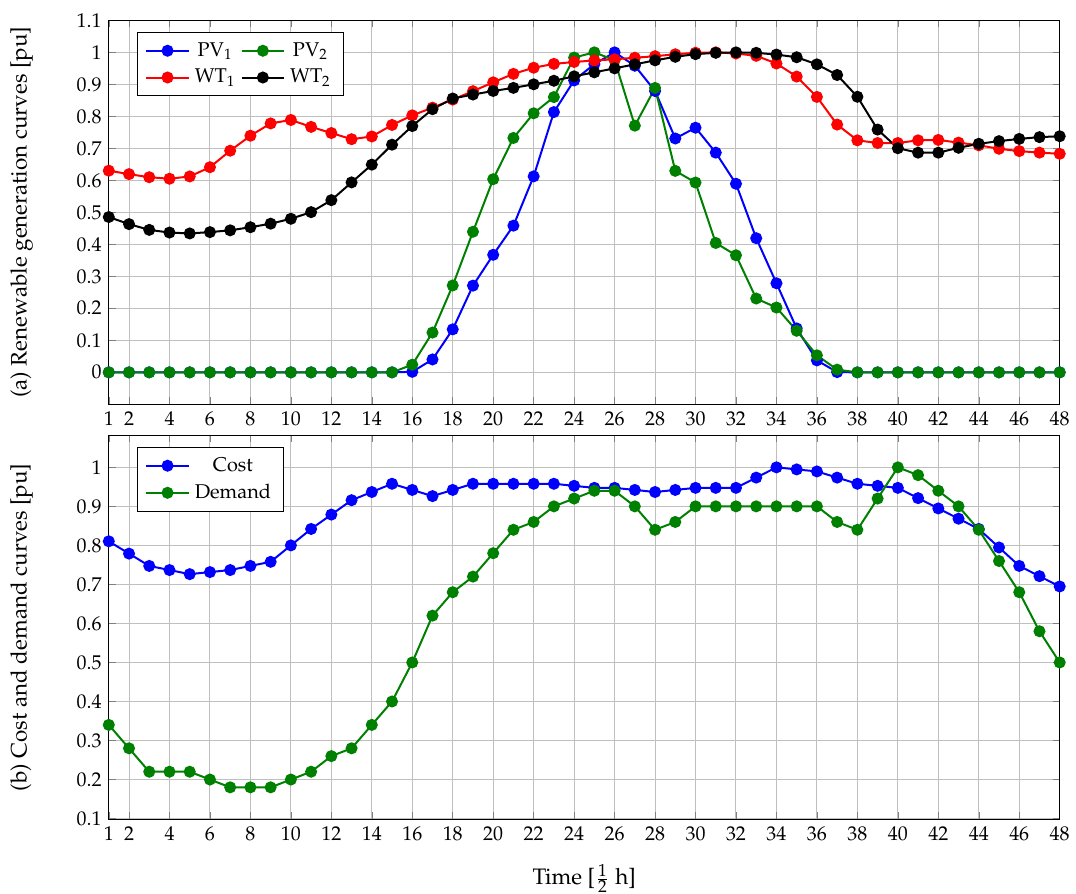
Figure 5. Operational curves for day-ahead economic dispatch approach: ( a ) renewable generation, and ( b ) demand and cost curves